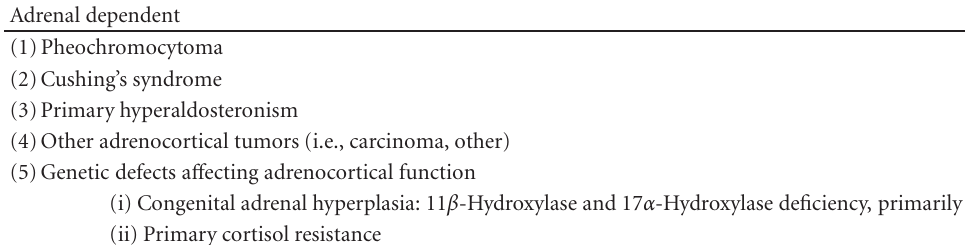
Table 1: Endocrine causes of hypertension.